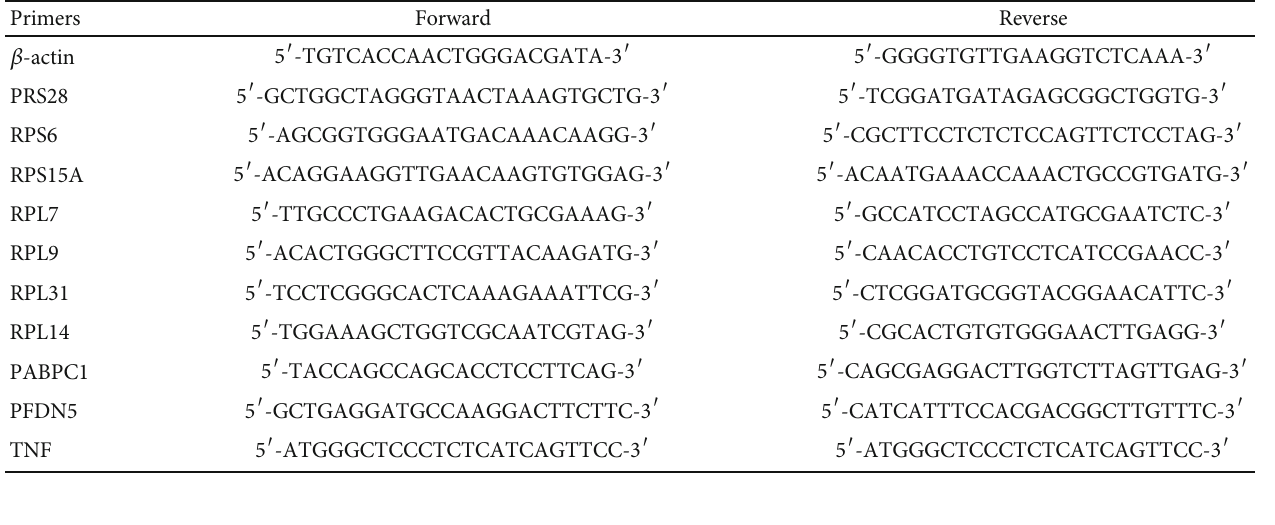
Table 1: The primers used in qRT-PCR.